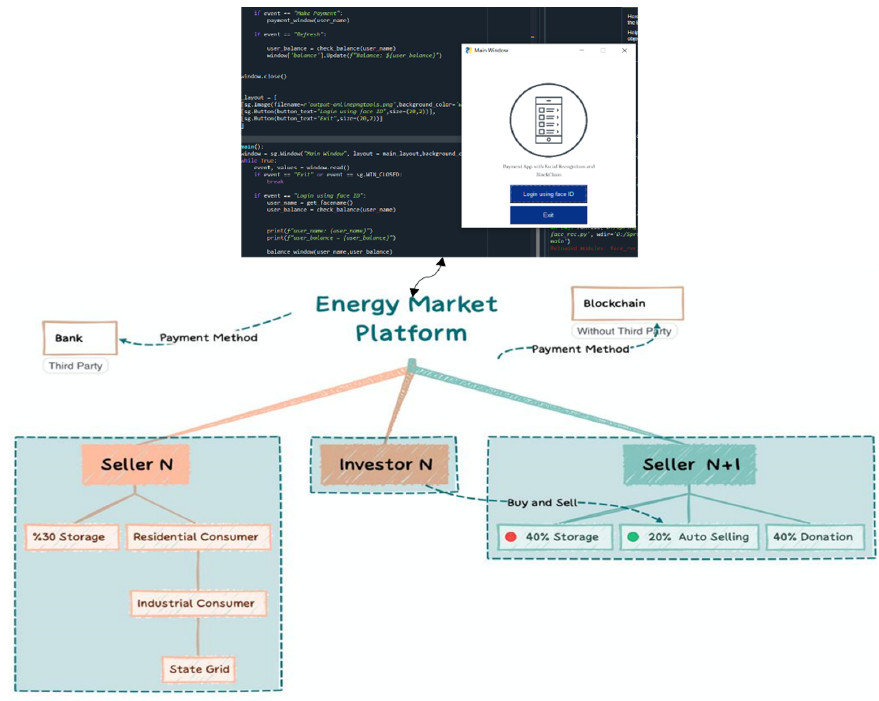
Figure 3. Energy trading